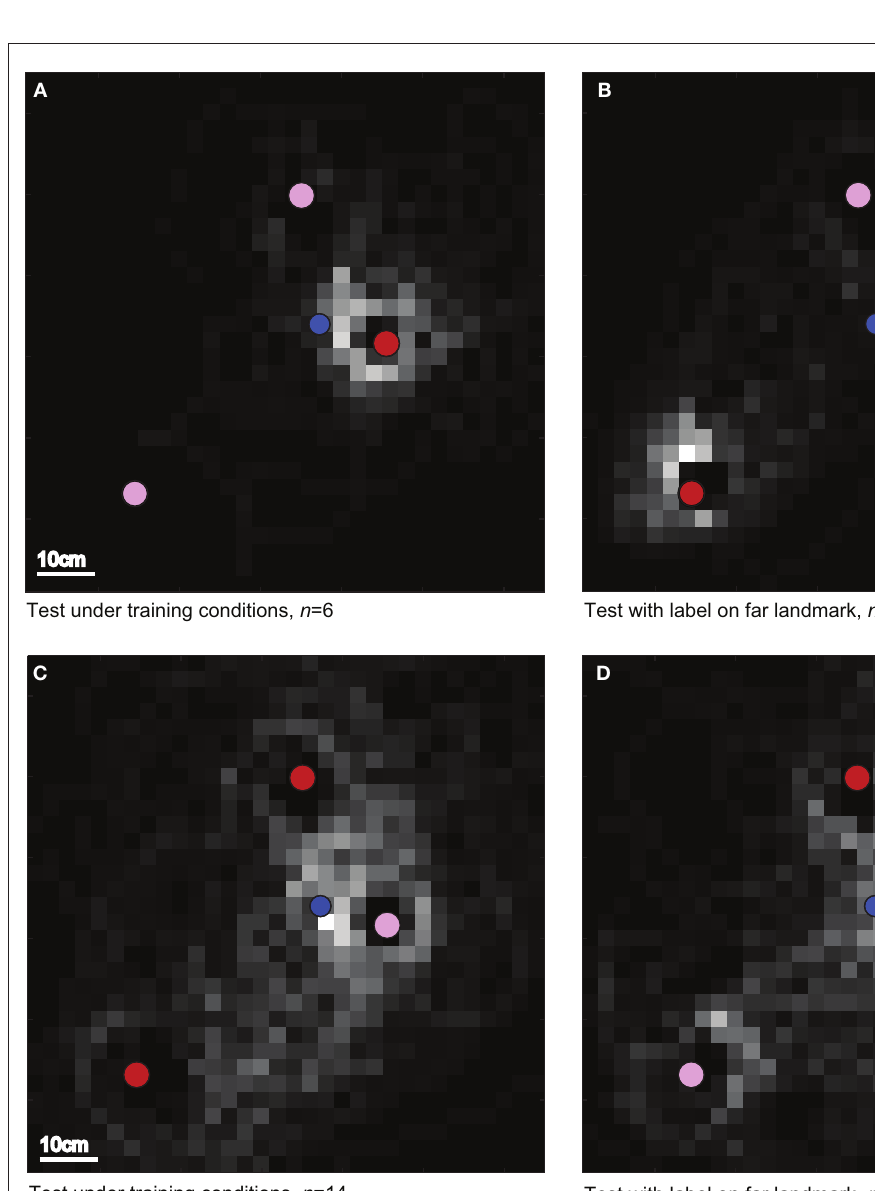
Figure 3 | Spatial search distributions with a red homogenous texture and a random dot pattern labeling the near landmark. To compare the search distributions of bees for the different test conditions, we calculated two-dimensional histograms of the time bees spent in one of 1024 3 × 3 cm fields in the field of view of the top camera. The bees’ search behavior was recorded under training conditions (A,C) with the feeder removed; each bee was tested once or twice. The landmark closest to the feeder (blue dot) was either